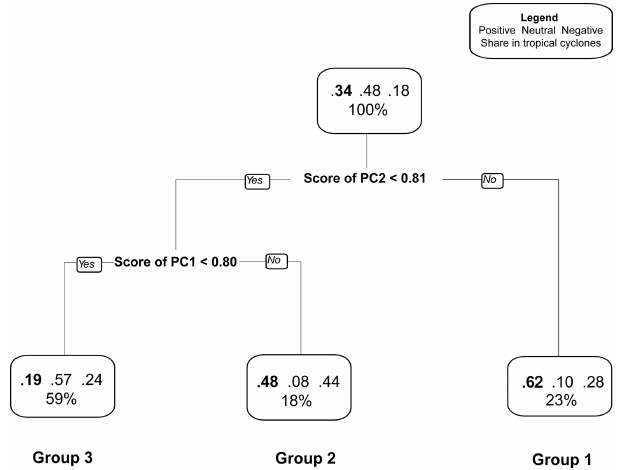
Figure A4. Decision tree proposing three groups of cyclones based on cyclone characteristics, surface properties mainly prior to the passage of the cyclone, and its effect on leaf area in the affected compared to the reference area. Each box shows the fractions of negative (right), neutral (middle), and positive (left) effect sizes (see also Table 1). The number of events is listed as the percentage of the total number of events in the random tree ( n = 1262). The first two principal components PC1 and PC2 (Table A2) were used to create a two-layer decision